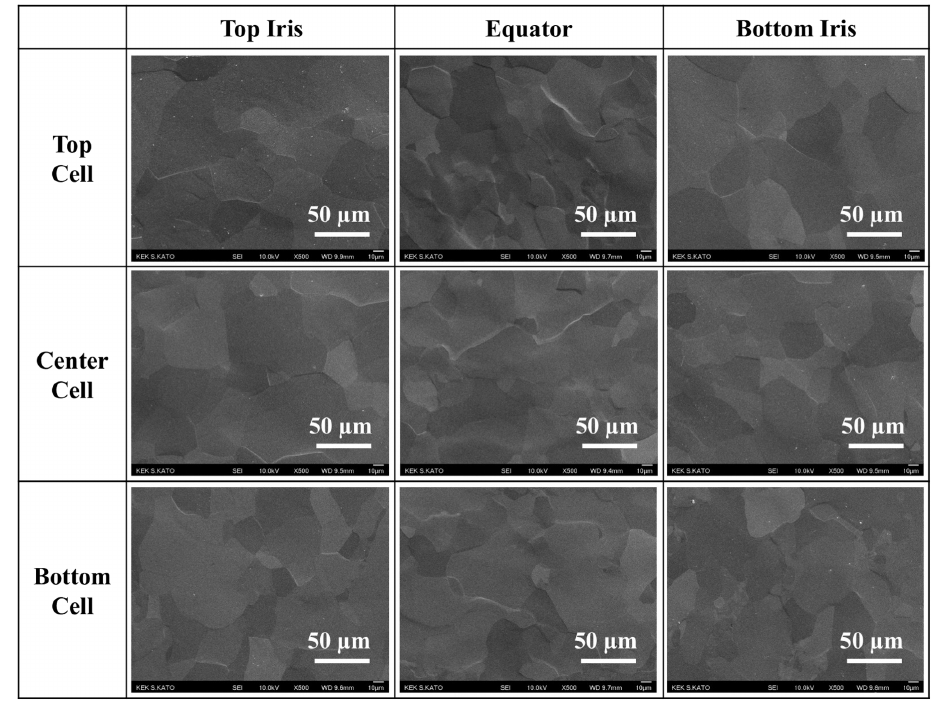
FIG. 20. SEM images of the coupons from the nine-cell coupon cavity after VEP performed for average removal of 25 μ m with the dual-flow method, a cathode rotation of 20 rpm, and a cavity temperature of ∼ 15